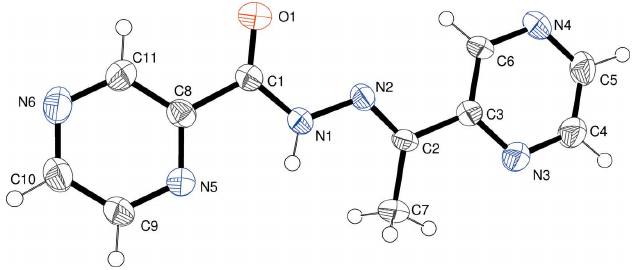
Figure 1 The title compound showing displacement ellipsoids drawn at the 50% probability